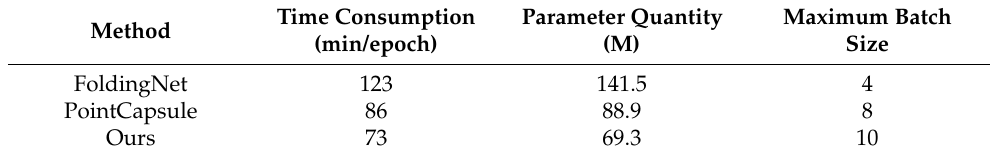
Table 7. Computational